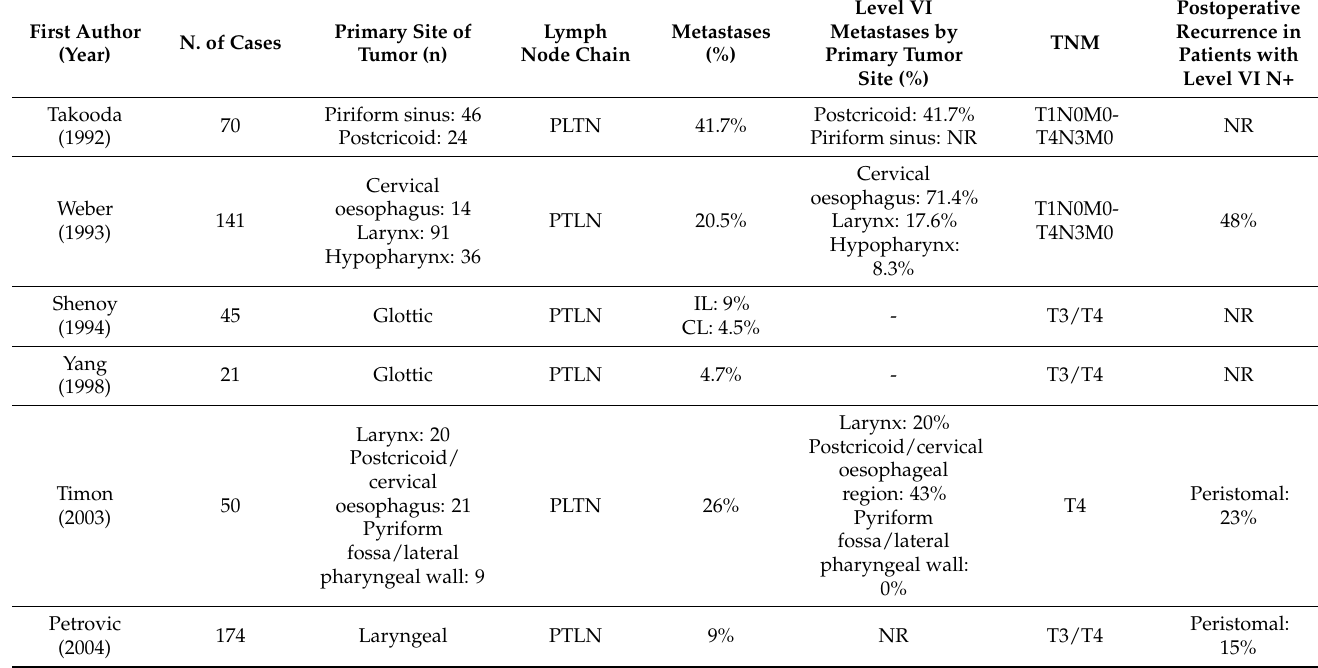
Table 1. Rate of central neck compartment involvement (author, year, site and subsite of the primary, category of the primary and treatment setting, overall central neck metastasis rate, occult central neck metastasis rate). CL, contralateral; IL, ipsilateral; NR, not reported; PTLN, paratracheal lymph